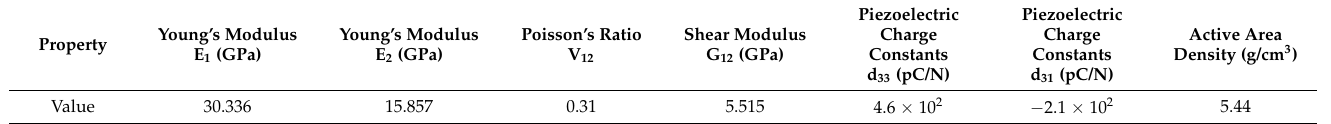
Table 2. MFC actuator material properties.